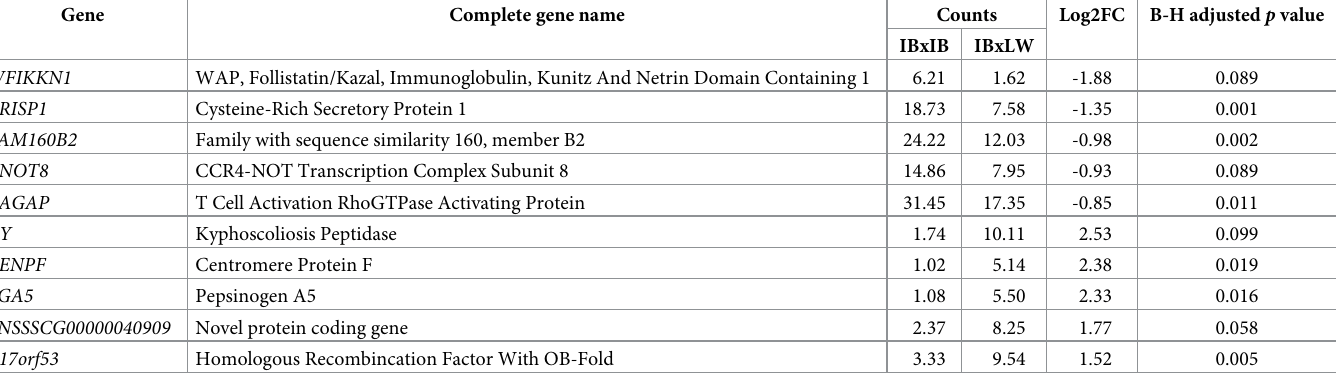
Table 2. Ten most significant differentially expressed genes (B-H adjusted p value < 0.1) calculated with DESeq2 from hypothalamic transcriptome data of 60 days-old pure Iberian and Iberian x Large White crossbred pigs.